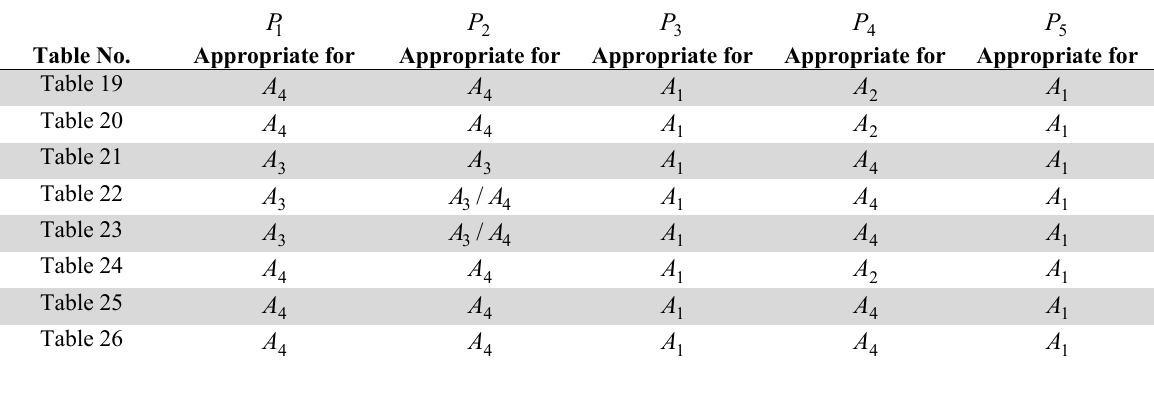
Appropriate for